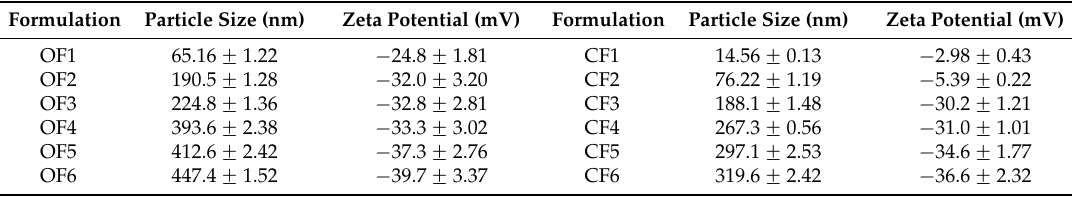
Table 5. Particle size and zeta potential of formulations OF1–OF6 and CF1–CF6. Formulation Particle Size (nm)